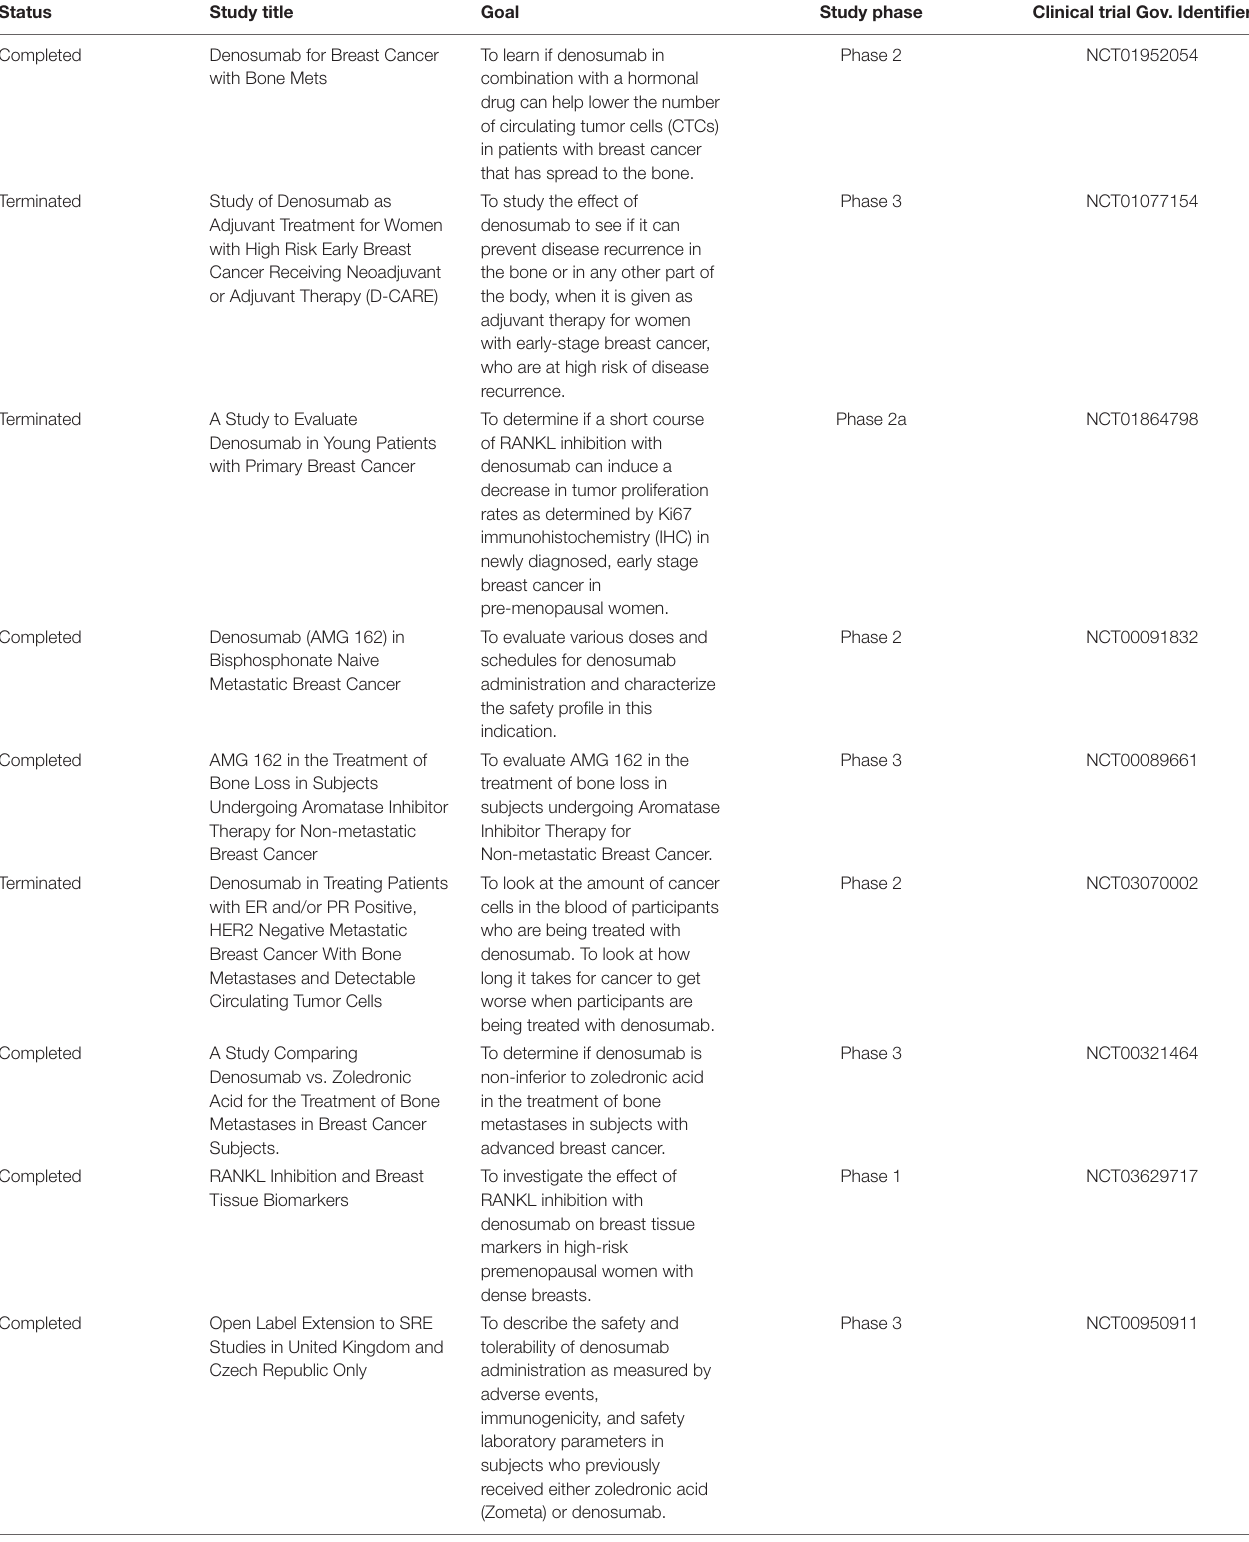
Clinical trial Gov.